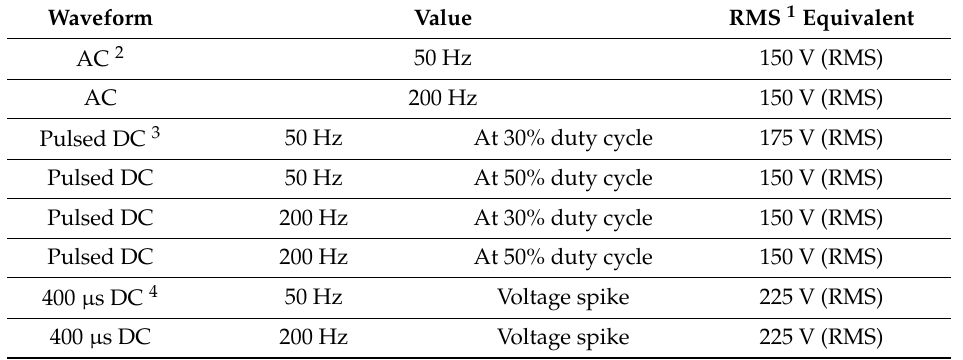
Table 2. Voltages that are expected to produce an e ff ective stun when applied head-only to turkeys.